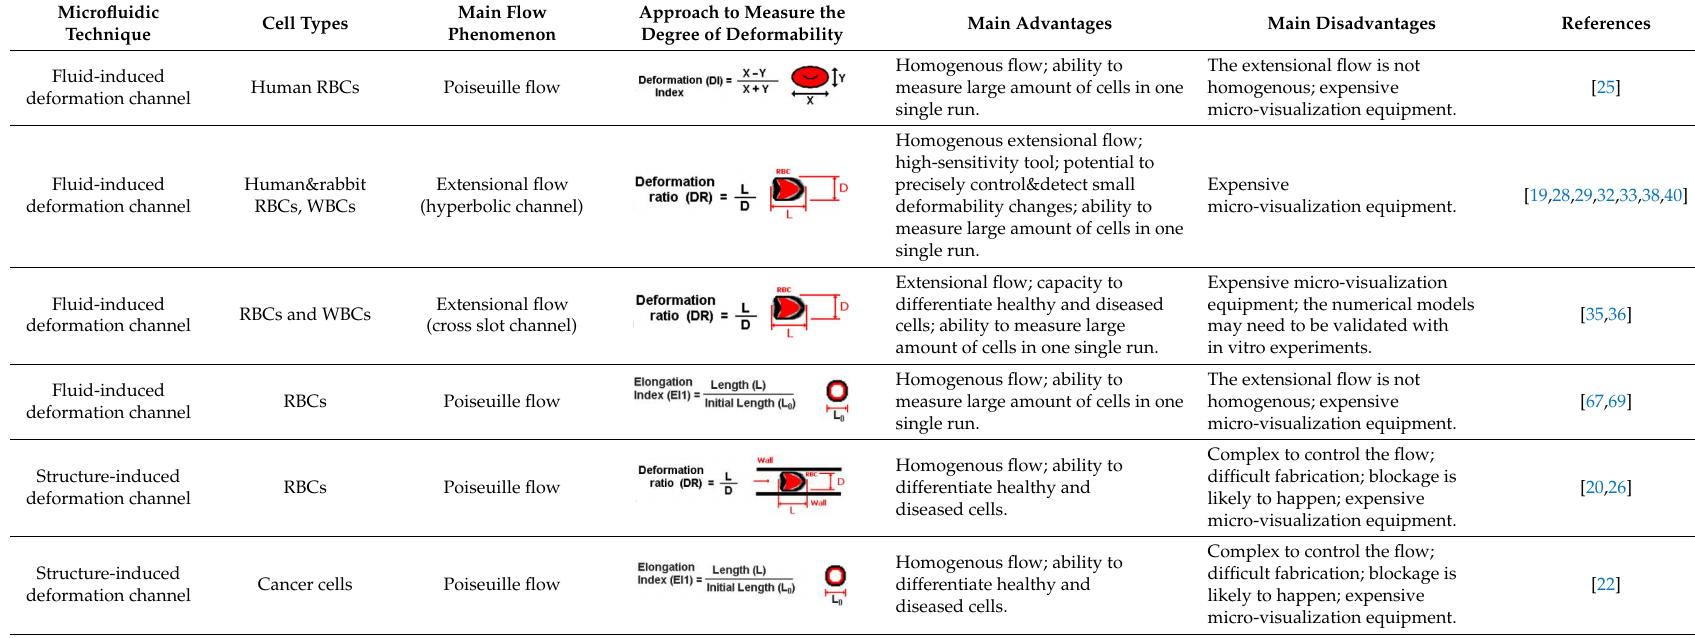
Table 2. Comparison of several cells deformability studies performed in microfluidic